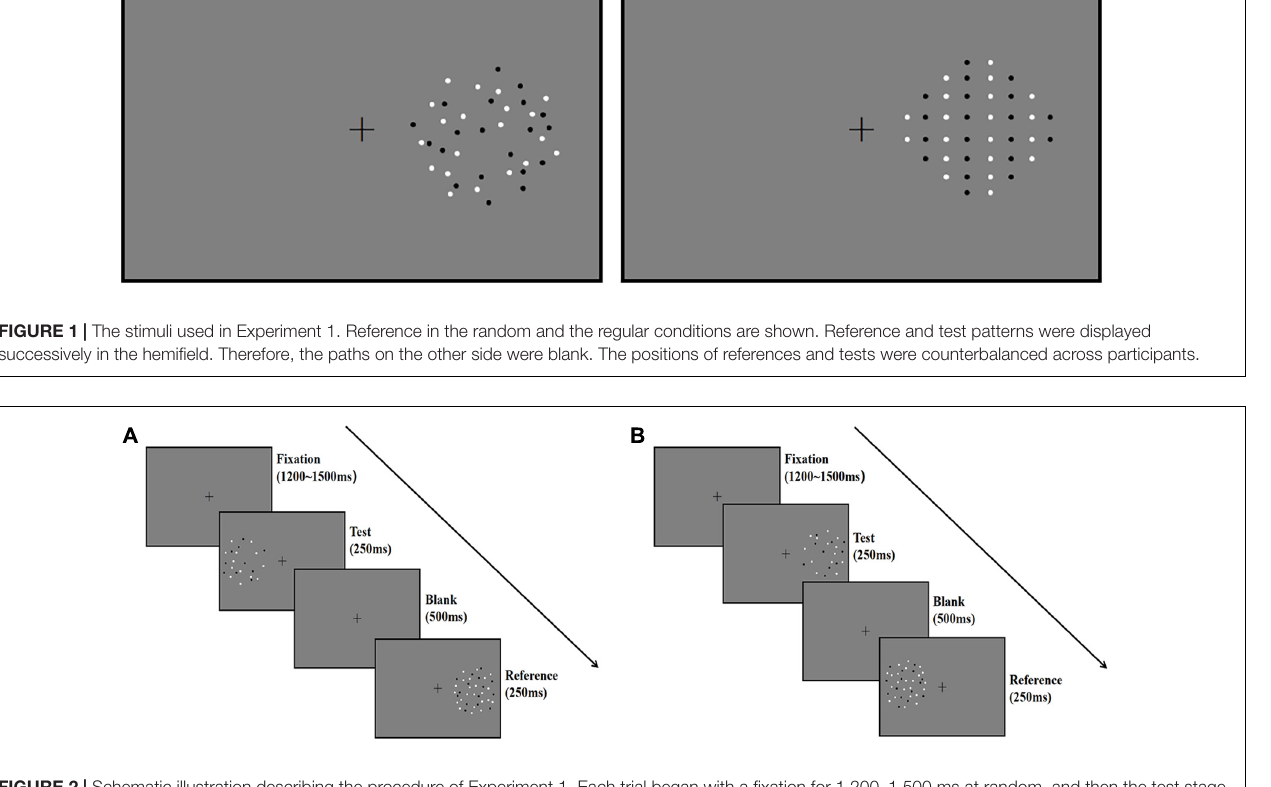
FIGURE 2 | Schematic illustration describing the procedure of Experiment 1. Each trial began with a fixation for 1,200–1,500 ms at random, and then the test stage began with a test stimulus displayed on one side of the screen for 250 ms, followed by a reference stimulus displayed on the other side for 250 ms. The two stimuli were separated by a blank screen lasting 500 ms. Participants fixed their gaze on the fixation point during the trial and reported which pattern (left or right) appeared to be more numerous; they guessed when they were unsure. (A) The test stimuli was presented on the left side. (B) The test stimuli was presented on the right